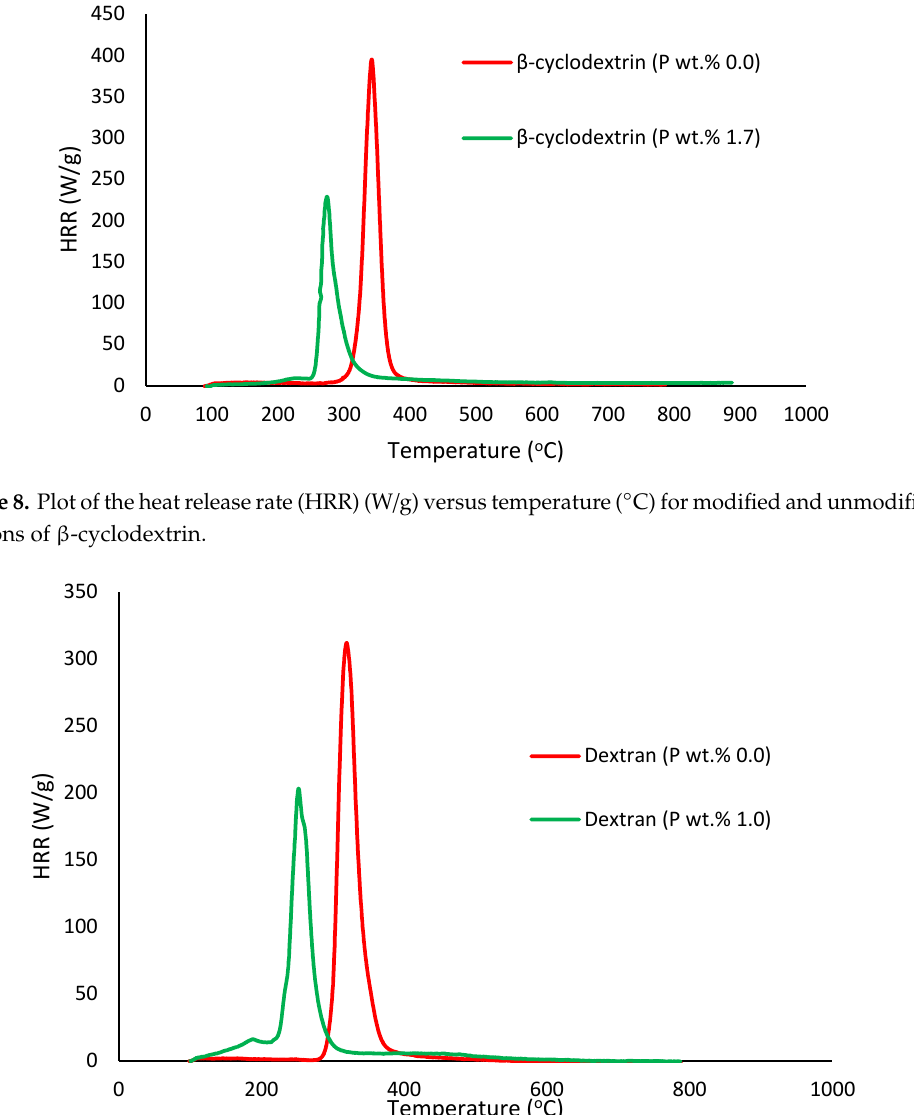
Figure 10. Plot of heat release rate (HRR) (W/g) versus temperature (°C) for modified and unmodified versions of potato starch.